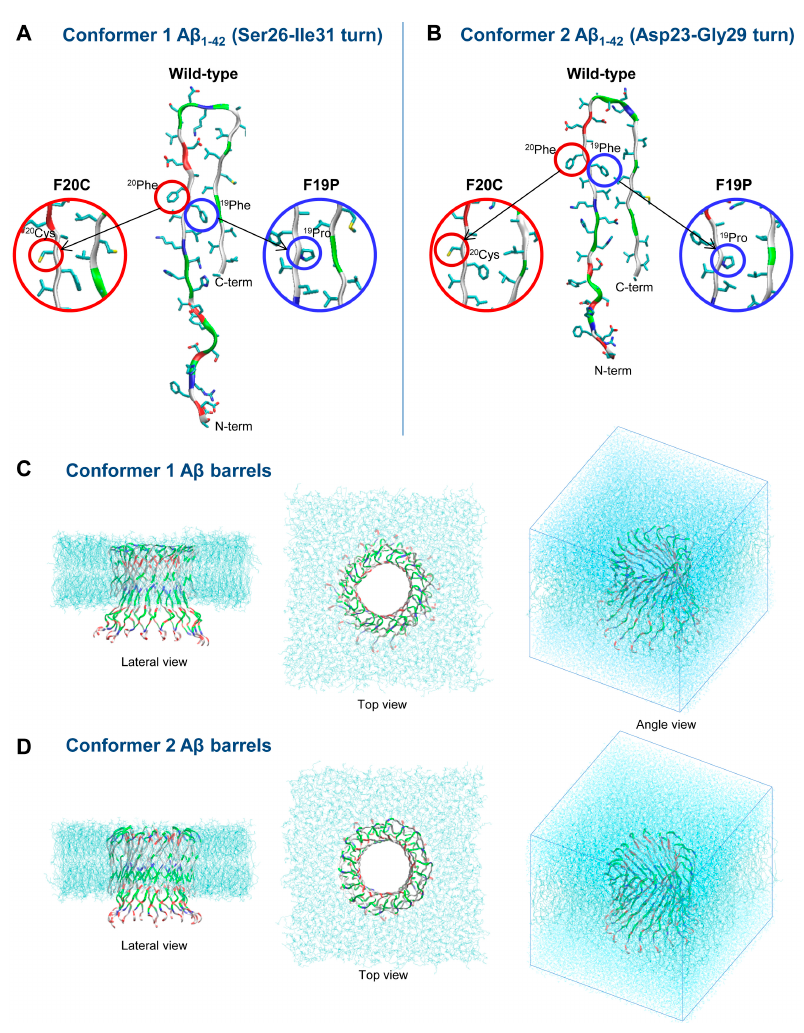
Figure 7. Monomer conformations of the A β 42 wild type and F19P and F20C mutants with different turns at ( A ) Ser26–Ile31 (conformer 1) and ( B ) Asp23–Gly29 (conformer 2). Starting points of the A β 42 barrels embedded in the lipid bilyer for the MD simulations for ( C ) conformer 1 and ( D ) conformer 2 A β 42 barrels. Waters were removed for the sake of clarity in the lateral and top views but they are depicted as cyan dots in the simulation box in the angle view. In the peptide ribbon, hydrophobic residues are colored white, polar and Gly residues are green, positively charged residues blue and negatively charged residues red.